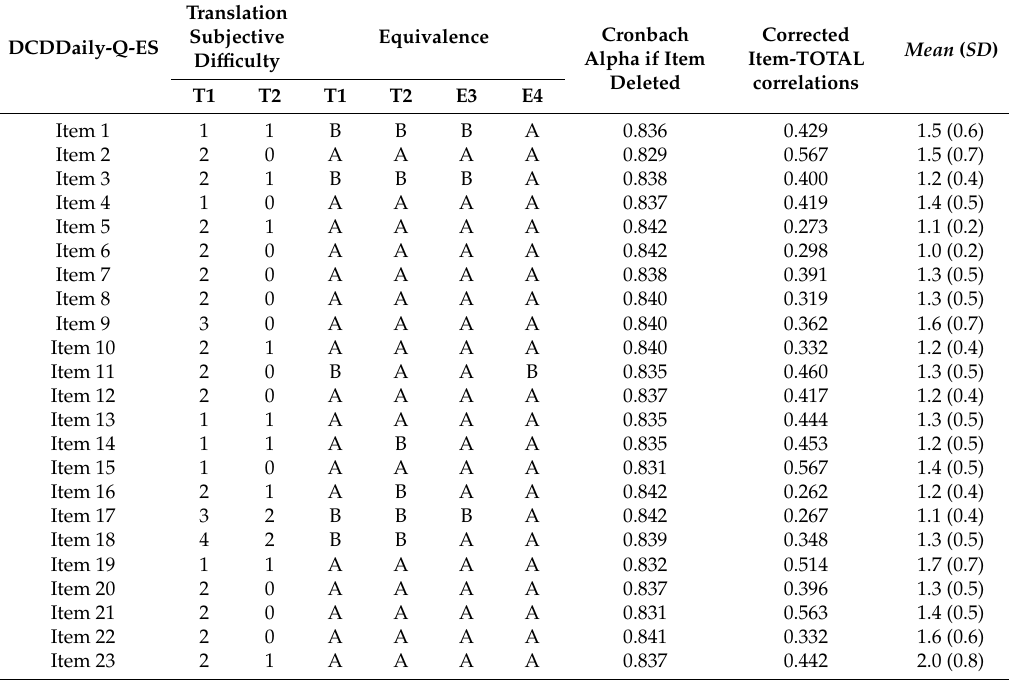
Table 2. Translation subjective di ffi culty, equivalence, and reliability properties of the DCDDaily-Q-ES. Translation DCDDaily-Q-ES